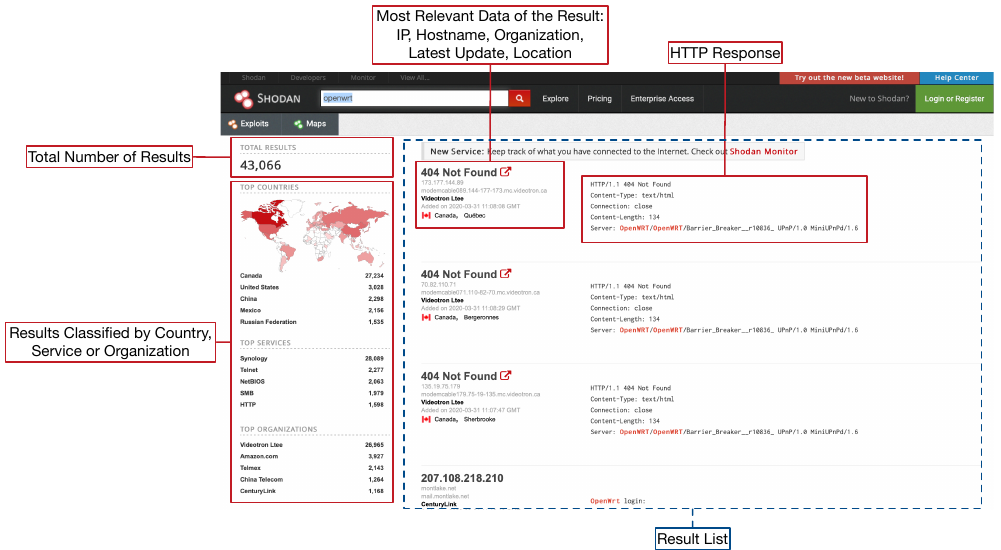
Figure 6. Example of Shodan result list